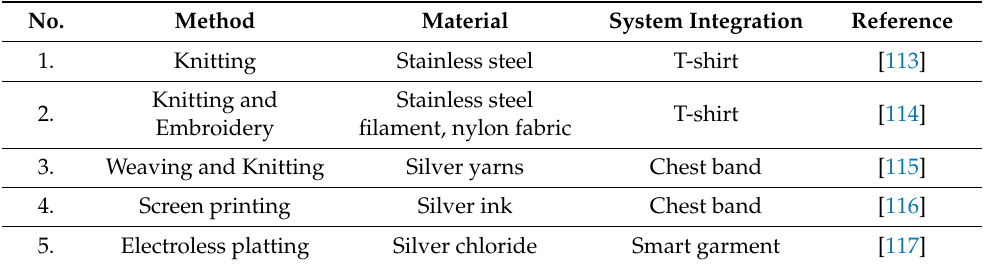
Table 3. Some examples of smart textile ECG